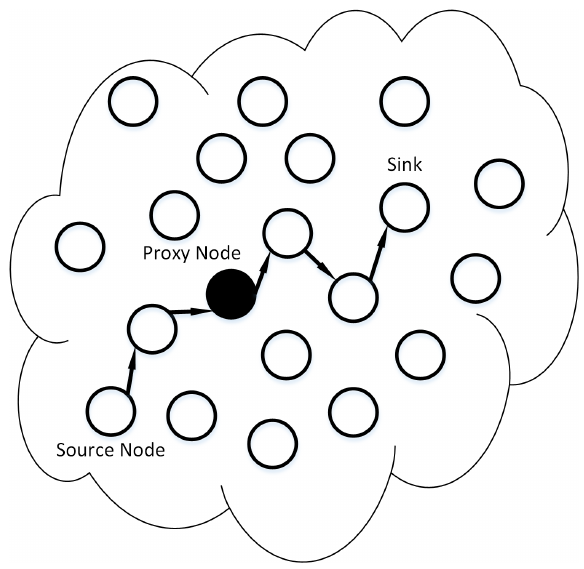
Figure 5. An example of PFS